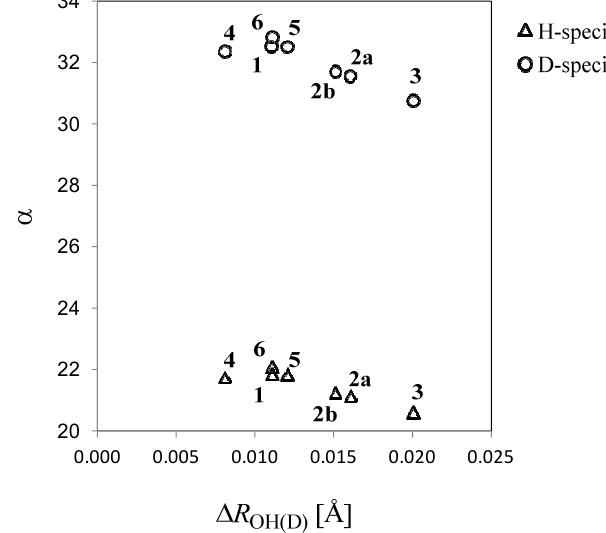
Figure 2. Correlation between the optimized α values and the changes in the R upon deuteration ∆ R OH(D)